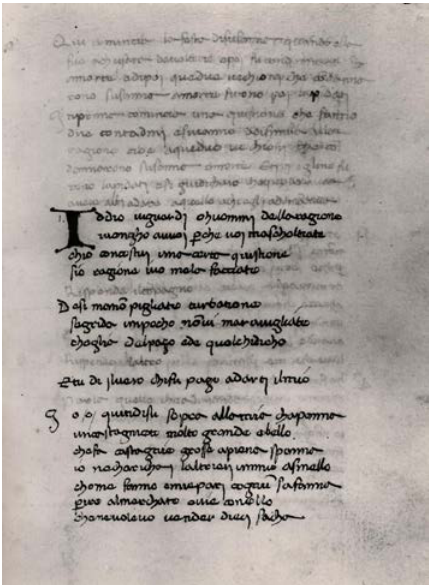
Figure 2 – La festa di Susanna , BNCF, ms. Conventi Soppressi F.3.488, f. 110r, around 1464. By permission of Ministero per i beni e le attività culturali / Biblioteca Nazionale Centrale. Firenze